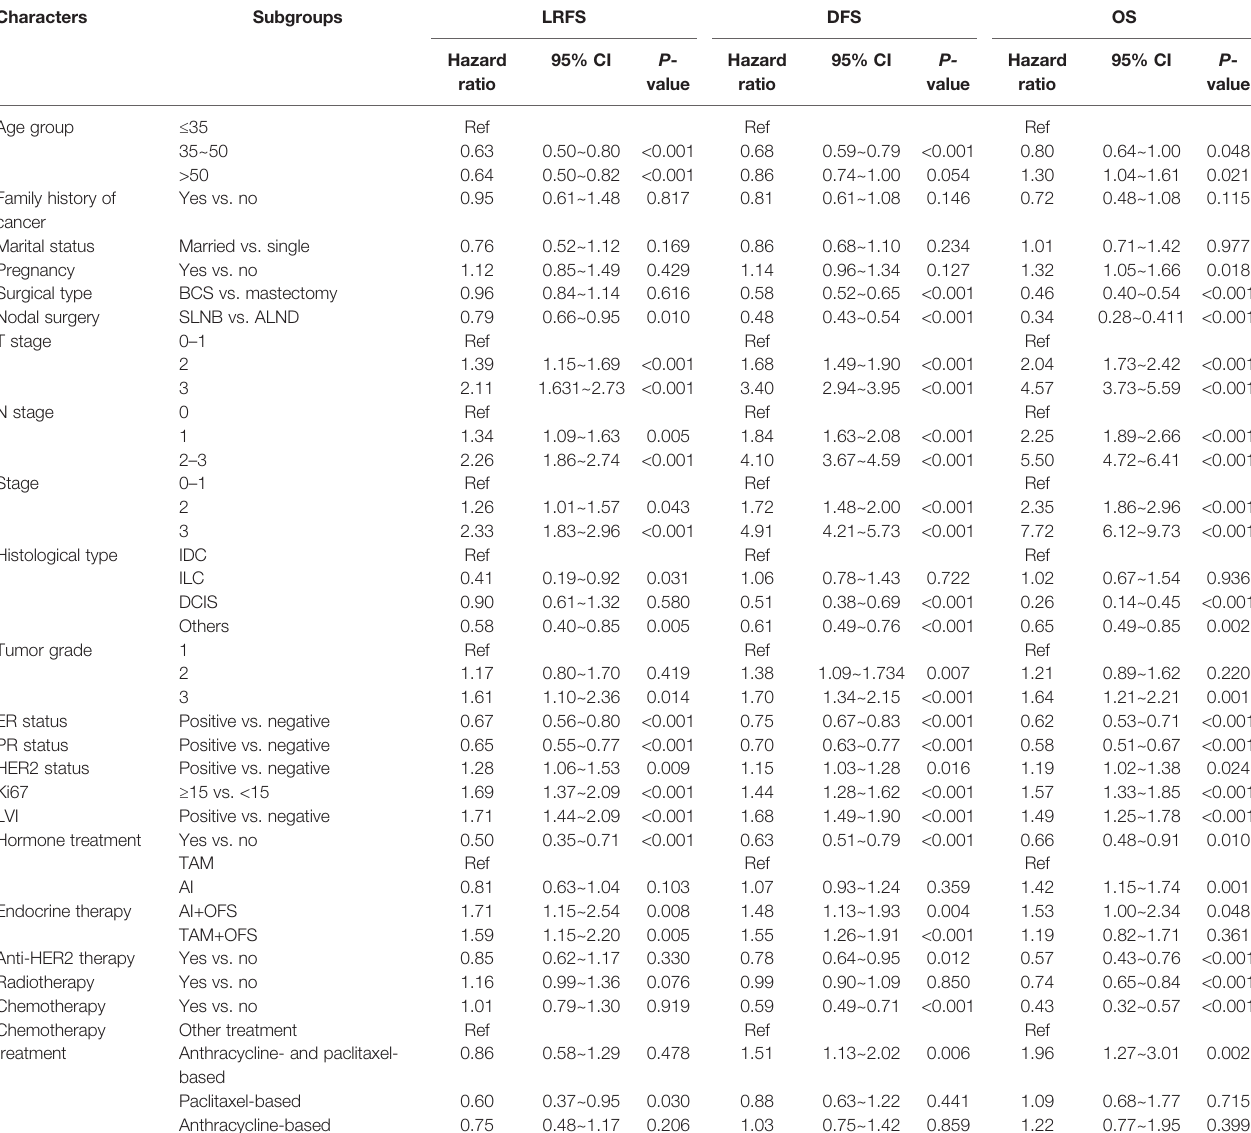
TABLE 3 | Univariable survival analyses for age and other clinicopathological